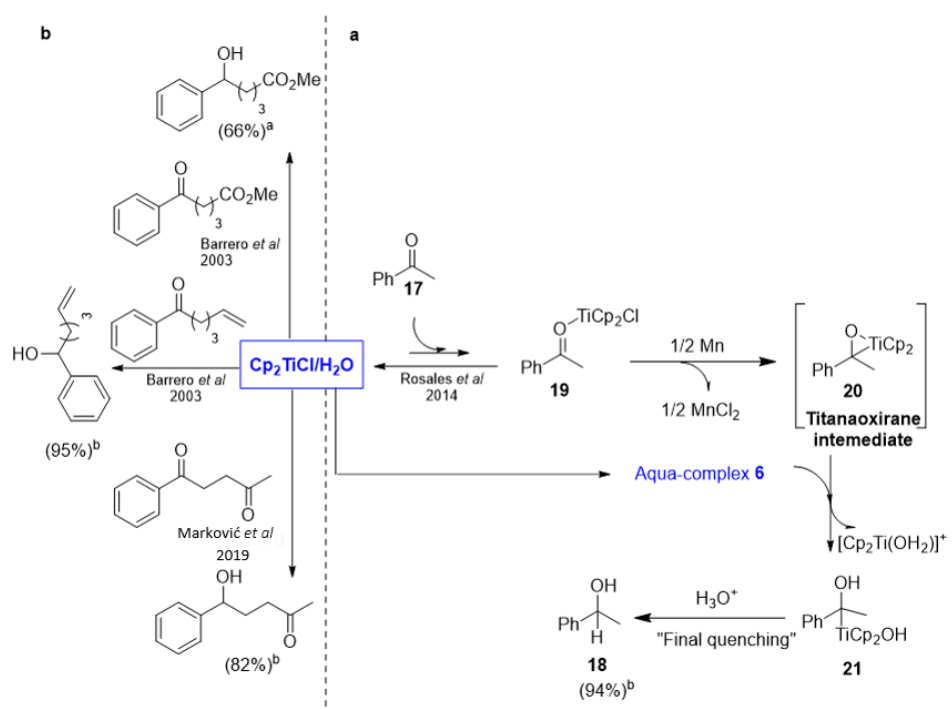
Scheme 10. ( a ) Proposed mechanism for the titanocene(III)/Mn-promoted reduction of